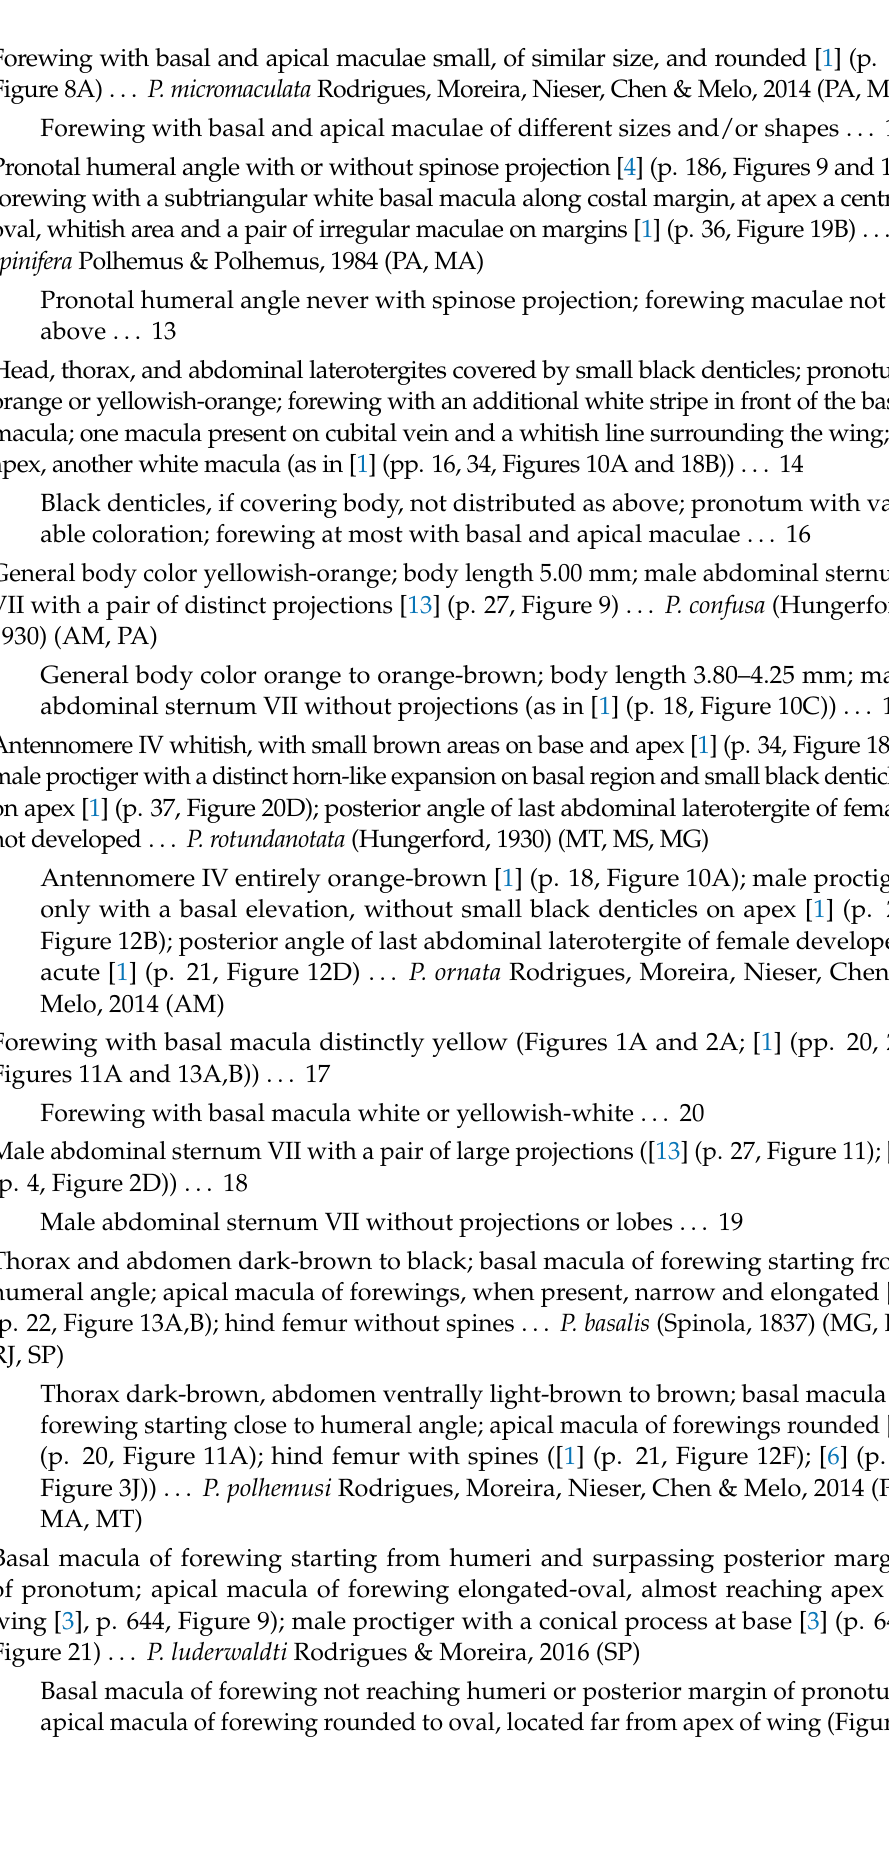
11. Forewing with basal and apical maculae small, of similar size, and rounded [1] (p. 16, Figure 8A) . . . P. micromaculata Rodrigues, Moreira, Nieser, Chen & Melo, 2014 (PA, MA) - Forewing with basal and apical maculae of different sizes and/or shapes . . . 12 12. Pronotal humeral angle with or without spinose projection [4] (p. 186, Figures 9 and 10); forewing with a subtriangular white basal macula along costal margin, at apex a central, oval, whitish area and a pair of irregular maculae on margins [1] (p. 36, Figure 19B) . . . P. spinifera Polhemus & Polhemus, 1984 (PA, MA) - Pronotal humeral angle never with spinose projection; forewing maculae not as above . . . 13 13. Head, thorax, and abdominal laterotergites covered by small black denticles; pronotum orange or yellowish-orange; forewing with an additional white stripe in front of the basal macula; one macula present on cubital vein and a whitish line surrounding the wing; at apex, another white macula (as in [1] (pp. 16, 34, Figures 10A and 18B)) . . . 14 - Black denticles, if covering body, not distributed as above; pronotum with vari- able coloration; forewing at most with basal and apical maculae . . . 16 14. General body color yellowish-orange; body length 5.00 mm; male abdominal sternum VII with a pair of distinct projections [13] (p. 27, Figure 9) . . . P. confusa (Hungerford, 1930) (AM, PA) - General body color orange to orange-brown; body length 3.80–4.25 mm; male abdominal sternum VII without projections (as in [1] (p. 18, Figure 10C)) . . . 15 15. Antennomere IV whitish, with small brown areas on base and apex [1] (p. 34, Figure 18B); male proctiger with a distinct horn-like expansion on basal region and small black denticles on apex [1] (p. 37, Figure 20D); posterior angle of last abdominal laterotergite of female not developed . . . P. rotundanotata (Hungerford, 1930) (MT, MS, MG) - Antennomere IV entirely orange-brown [1] (p. 18, Figure 10A); male proctiger only with a basal elevation, without small black denticles on apex [1] (p. 21, Figure 12B); posterior angle of last abdominal laterotergite of female developed, acute [1] (p. 21, Figure 12D) . . . P. ornata Rodrigues, Moreira, Nieser, Chen & Melo, 2014 (AM) 16. Forewing with basal macula distinctly yellow (Figures 1A and 2A; [1] (pp. 20, 22, Figures 11A and 13A,B)) . . . 17 - Forewing with basal macula white or yellowish-white . . . 20 17. Male abdominal sternum VII with a pair of large projections ([13] (p. 27, Figure 11); [6] (p. 4, Figure 2D)) . . . 18 - Male abdominal sternum VII without projections or lobes . . . 19 18. Thorax and abdomen dark-brown to black; basal macula of forewing starting from humeral angle; apical macula of forewings, when present, narrow and elongated [1] (p. 22, Figure 13A,B); hind femur without spines . . . P. basalis (Spinola, 1837) (MG, ES, RJ, SP) - Thorax dark-brown, abdomen ventrally light-brown to brown; basal macula of forewing starting close to humeral angle; apical macula of forewings rounded [1] (p. 20, Figure 11A); hind femur with spines ([1] (p. 21, Figure 12F); [6] (p. 6, Figure 3J)) . . . P. polhemusi Rodrigues, Moreira, Nieser, Chen & Melo, 2014 (PA, MA, MT) 19. Basal macula of forewing starting from humeri and surpassing posterior margin of pronotum; apical macula of forewing elongated-oval, almost reaching apex of wing [3], p. 644, Figure 9); male proctiger with a conical process at base [3] (p. 646, Figure 21) . . . P. luderwaldti Rodrigues & Moreira, 2016